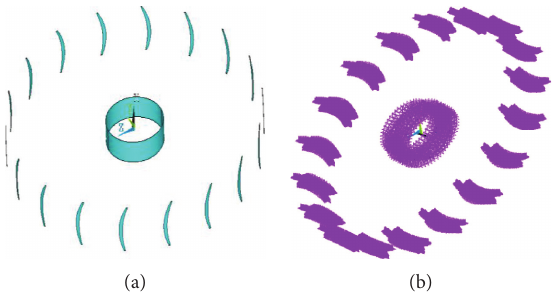
Figure 4: Master DOFs of the MTB. (a) Interfaces of master DOFs. (b) Master DOFs.